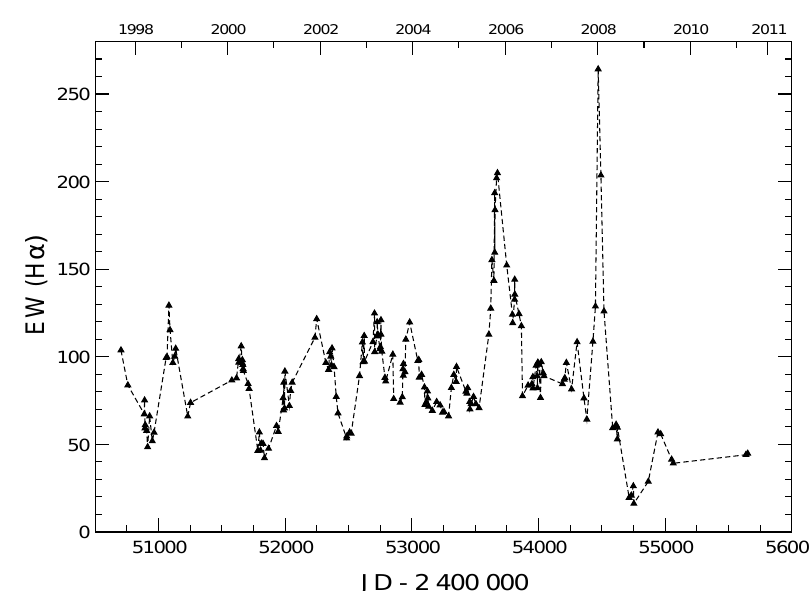
Fig. 2. EWs of the H (cid:11) line in the spectrum of AG Dra in